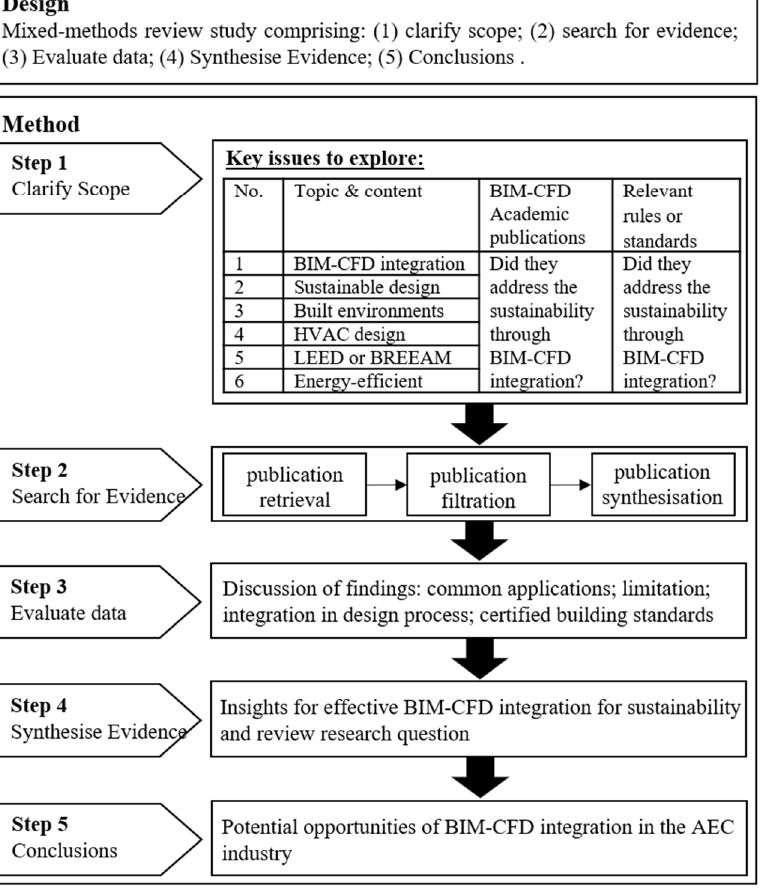
Figure 1. Flowchart of the five-stage review study.